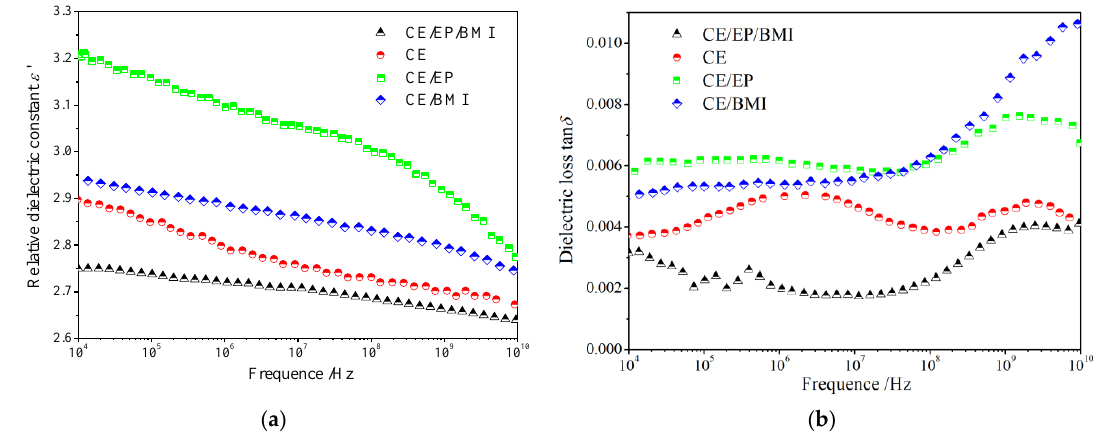
Figure 6. Complex dielectric functions of the pure CE and CE/EP, CE/BMI, and CE/BMI/EP composites: ( a ) relative dielectric constant and ( b ) dielectric loss tan δ .